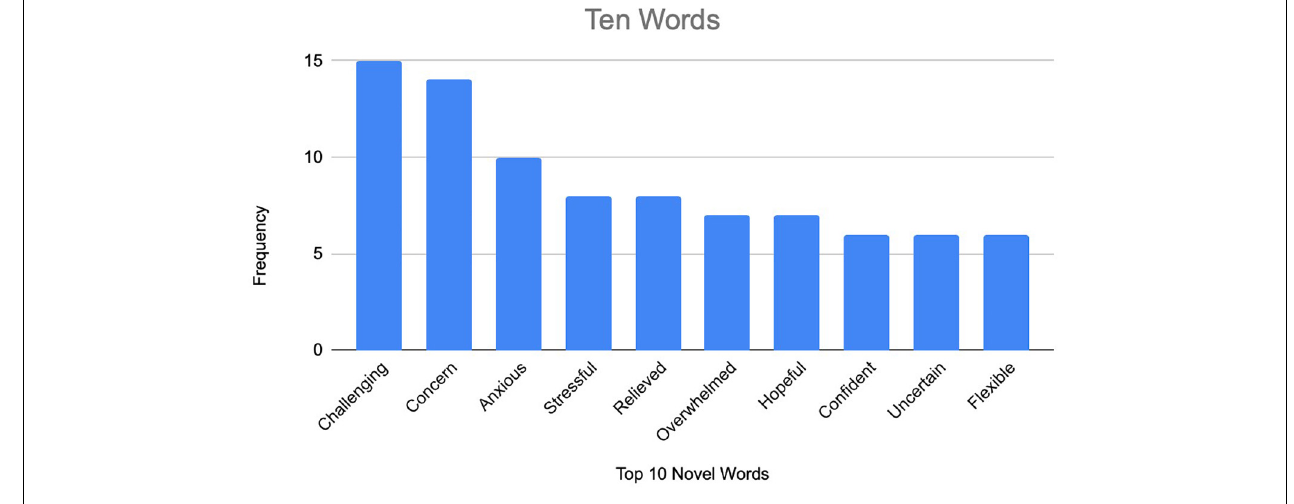
FIGURE 2 | Top 10 novel words.